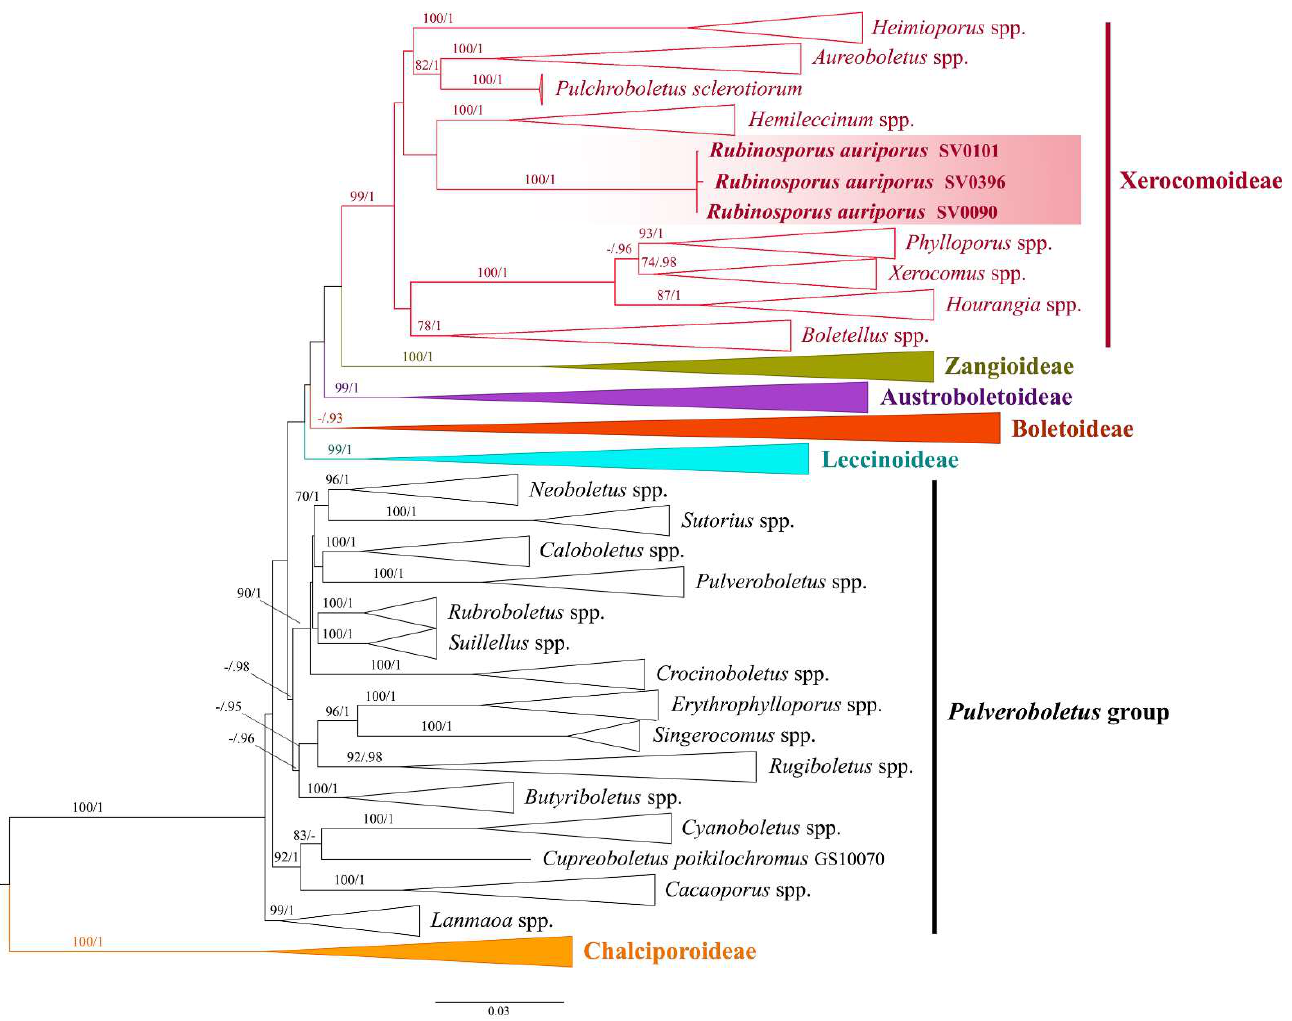
Figure 1. Boletaceae-wide Maximum Likelihood phylogenetic tree inferred from the four-gene dataset ( atp 6, cox 3, rpb 2, and tef 1) (introns excluded), showing position of the new genus Rubinosporus in Xerocomoideae. Bootstrap support values (BS ≥ 70%) and the corresponding Bayesian posterior probabilities (PP ≥ 0.90) are shown above the supported branches. The two Buchwaldoboletus and seven Chalciporus species (subfamily Chalciporoideae) were used as the outgroup. All taxa belonging to subfamilies Austroboletoideae, Boletoideae, Chalciporoideae, Leccinoideae, and Zangioideae were collapsed into subfamily clades. All generic clades in subfamily Xerocomoideae and Pulveroboletus group that were highly supported were also